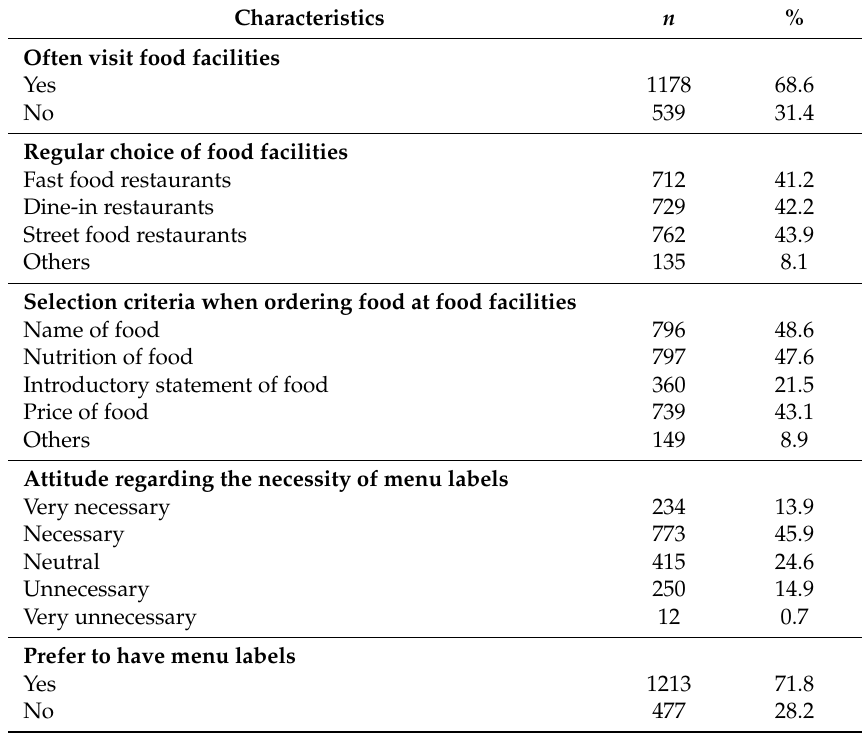
Table 2. Attitude and preference for calories and nutrition labeling among customers.